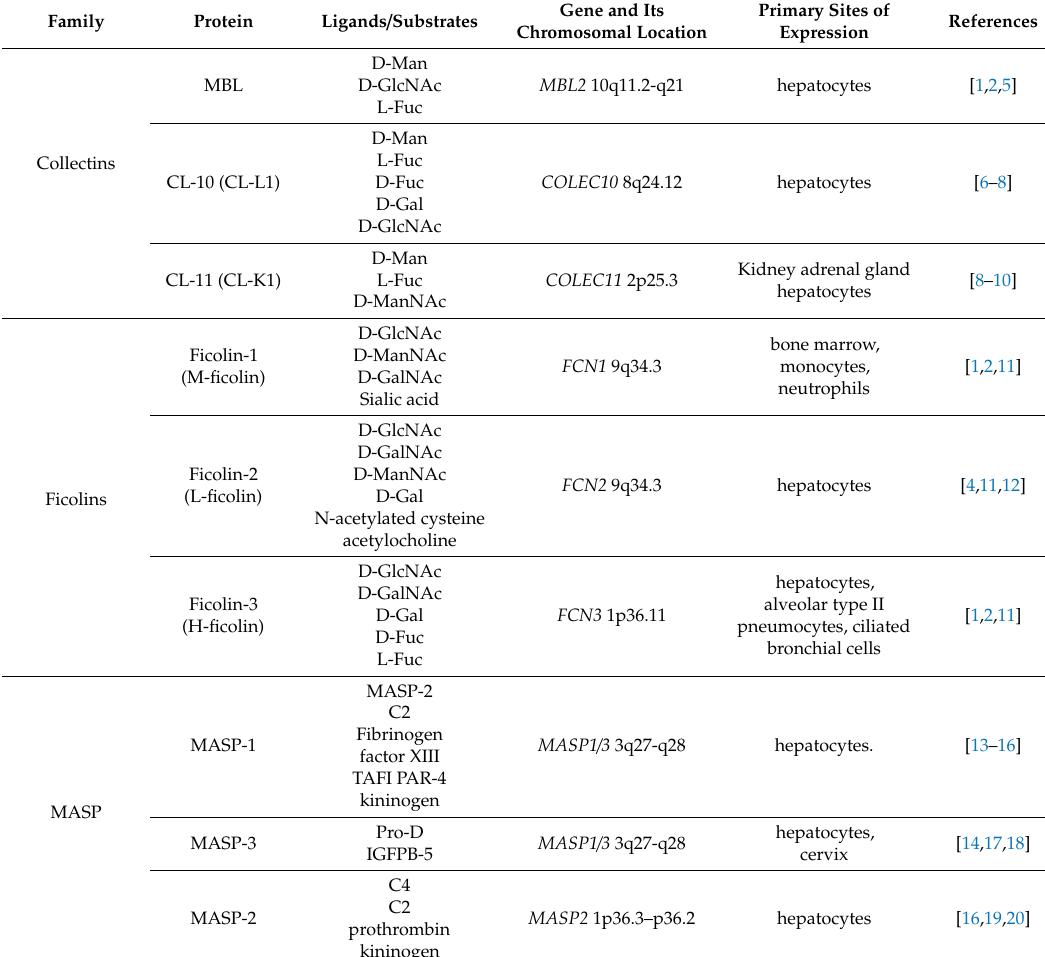
Table 1. Collectins and ficolins—pattern recognition molecules initiating activation of complement via the lectin pathway and their associated serine proteases (mannose-binding lectin-associated serine proteases